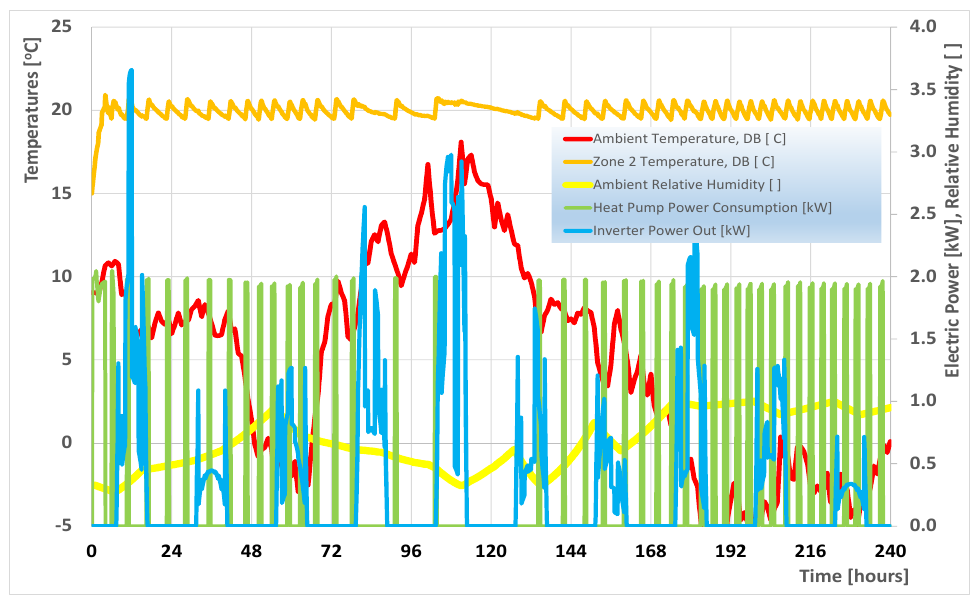
Figure 3. Ambient conditions, room temperature, heat pump electricity consumption and electric power at the PV inverter outlet, during the first 10 days of January. The room thermostat, which controls the heat pump operation, is set to 20 °C. South facing PV panels tilted 30 degrees.